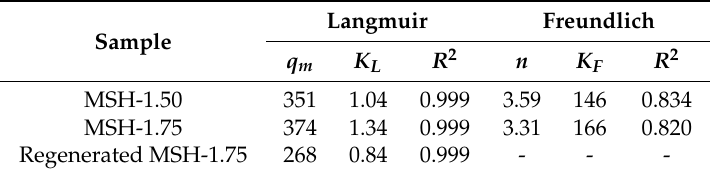
Table 3. Langmuir and Freundlich isotherms parameters of MSH-1.50, MSH-1.75 and